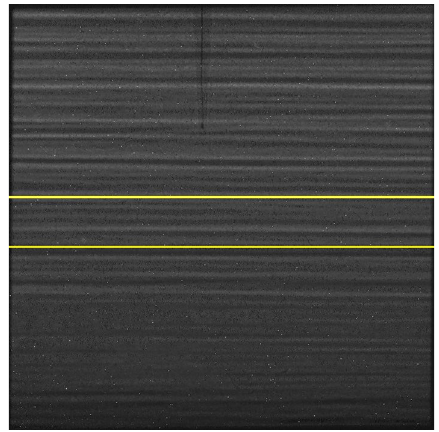
Figure 7. X-ray transmission image of a 5 mm × 5 mm irradiated region and the hydrogen probe tip centrally above it. Images such as this were used to determine the distance from the probe tip to the irradiated region. Yellow lines outline the region that was irradiated. Figure made with an image processed by FIJI 56